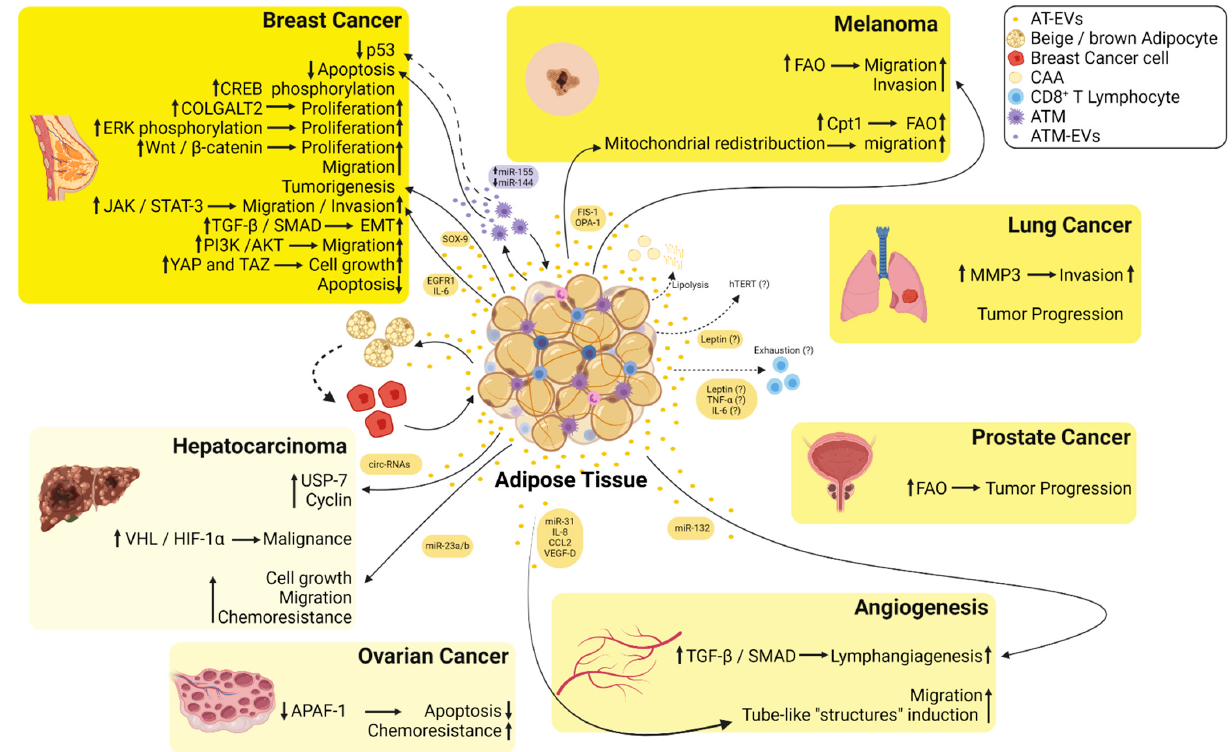
Figure 2. Summary of the crosstalk between the EVs derived from adipose tissues (AT-EVs) and several types of cancers. EVs released from adipose tissue macrophages are enriched in miR-155, whereas miR-144 is downregulated inducing inhibition of p53 and decreased apoptosis in breast cancer cells. AT-EVs increase phosphorylation of cAMP response element-binding (CREB) protein increasing the proliferation of breast cancer cells. AT-EVs increase the proliferation of breast cancer cells via induction of procollagen galactosyltransferase 2 (COLGALT2). AT-EVs increase extracellular signal- regulated kinase (ERK) and Wnt/ β -catenin signaling pathways inducing an increase in the proliferation of breast cancer cells. AT-EVs enriched in SRY-box transcription factor 9 (SOX-9) induce tumorigenesis in breast cancer cells. AT-EVs from diabetic patients are enriched in epidermal growth factor receptor 1 (EGFR1)/interleukin 6 (IL-6) and induce an increase in migration and invasion of breast cancer cells via Janus kinase (JAK)/signal transducer and activator of transcription 3 (STAT-3) signaling. AT-EVs increase TGF- β /SMAD signaling pathway triggering epithelial-mesenchymal transition (EMT) in non-metastatic breast cancer cells. AT-EVs induce PI3K/AKT signaling in MDA-MB-231 cells, thus increasing their migratory capacity. AT-EVs induce yes-associated protein 1 (YAP) and taffazin (TAZ) inducing cell growth in breast cancer cells. AT-EVs decrease apoptosis in breast cancer cells. AT-EVs enriched in mitochondrial fission protein 1 (FIS-1) and mitochondrial dynamin-like GTPase (OPA-1) induce mitochondrial redistribution toward the edge of melanoma cells increasing their migratory capacity. AT-EVs and EVs derived from cancer-associated adipocytes (CAA) fuel free fatty acids to melanoma cells and increase fatty acid oxidation (FAO) increasing their migratory and invasive capacities. AT-EVs increase metalloproteinase 3 (MMP-3) in lung cancer cells increasing their invasiveness. AT-EVs increase tumor progression of lung cancer. AT-EVs increase FAO and induce tumor progression in prostate cancer. AT-EVs enriched in circulating RNAs (circ-RNAs) induce hypophosphorylation of ubiquitin-specific-processing protease 7 (USP-7) and an increase in cyclin in hepatocarcinoma cells. AT-EVs induce malignancy of hepatocarcinoma cells via hypoxia-inducible factor 1 α (HIF-1 α ) binding to the von-Hippel Lindau tumor suppressor (VHL). AT-EVs decrease apoptosis and increase chemoresistance in ovarian cancer cells via inhibition of the apoptotic peptidase activator factor 1 (APAF-1). AT-EVs enriched in miR-31, interleukin 8 (IL-8), C-C motif chemokine ligand 2 (CCL2), and vascular endothelial growth factor-D (VEGF-D) induce the formation of tube-like structures by endothelial cells. AT-EVs enriched in miR-132 induce lymphangiogenesis via transforming growth factor β (TGF- β )/Smad signaling. CAA undergo increased lipolysis and differentiate toward beige/brown adipocytes phenotype fueling tumor cells with EVs. Leptin released from AT is possibly within EVs and induces an increase in telomerase reverse transcriptase (hTERT) activity inducing resistance to apoptosis and senescence. Leptin, TNF- α , and IL-6 may be released from AT-EVs, inducing CD8 + T cells’ exhaustion.